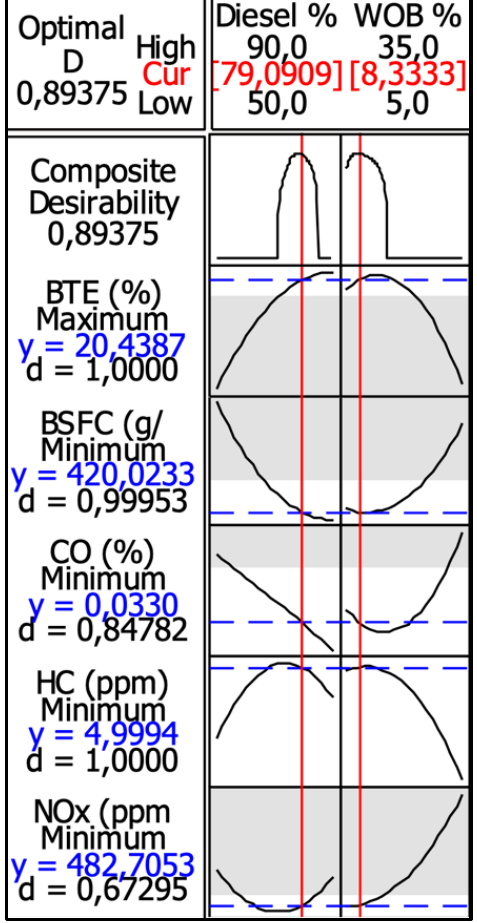
Figure 2. Optimized concentration and outputs.